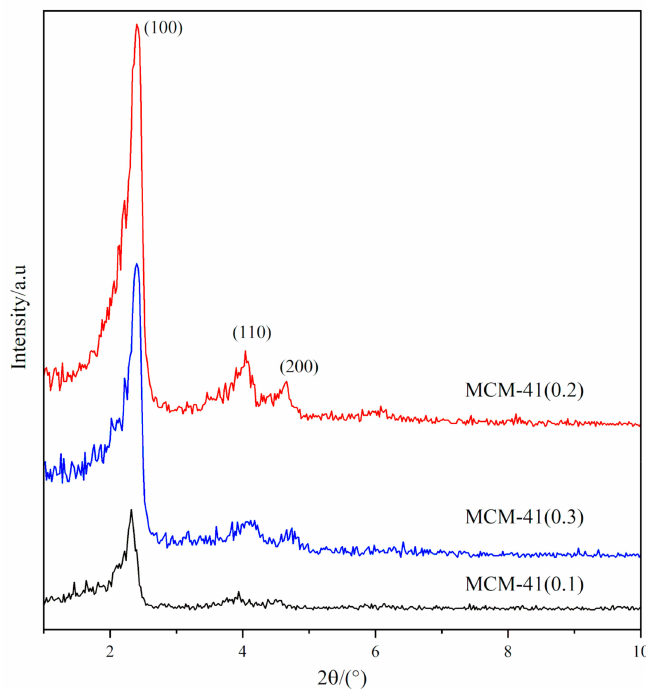
Figure 6. XRD patterns of MCM-41 with di ff erent ratio of template.